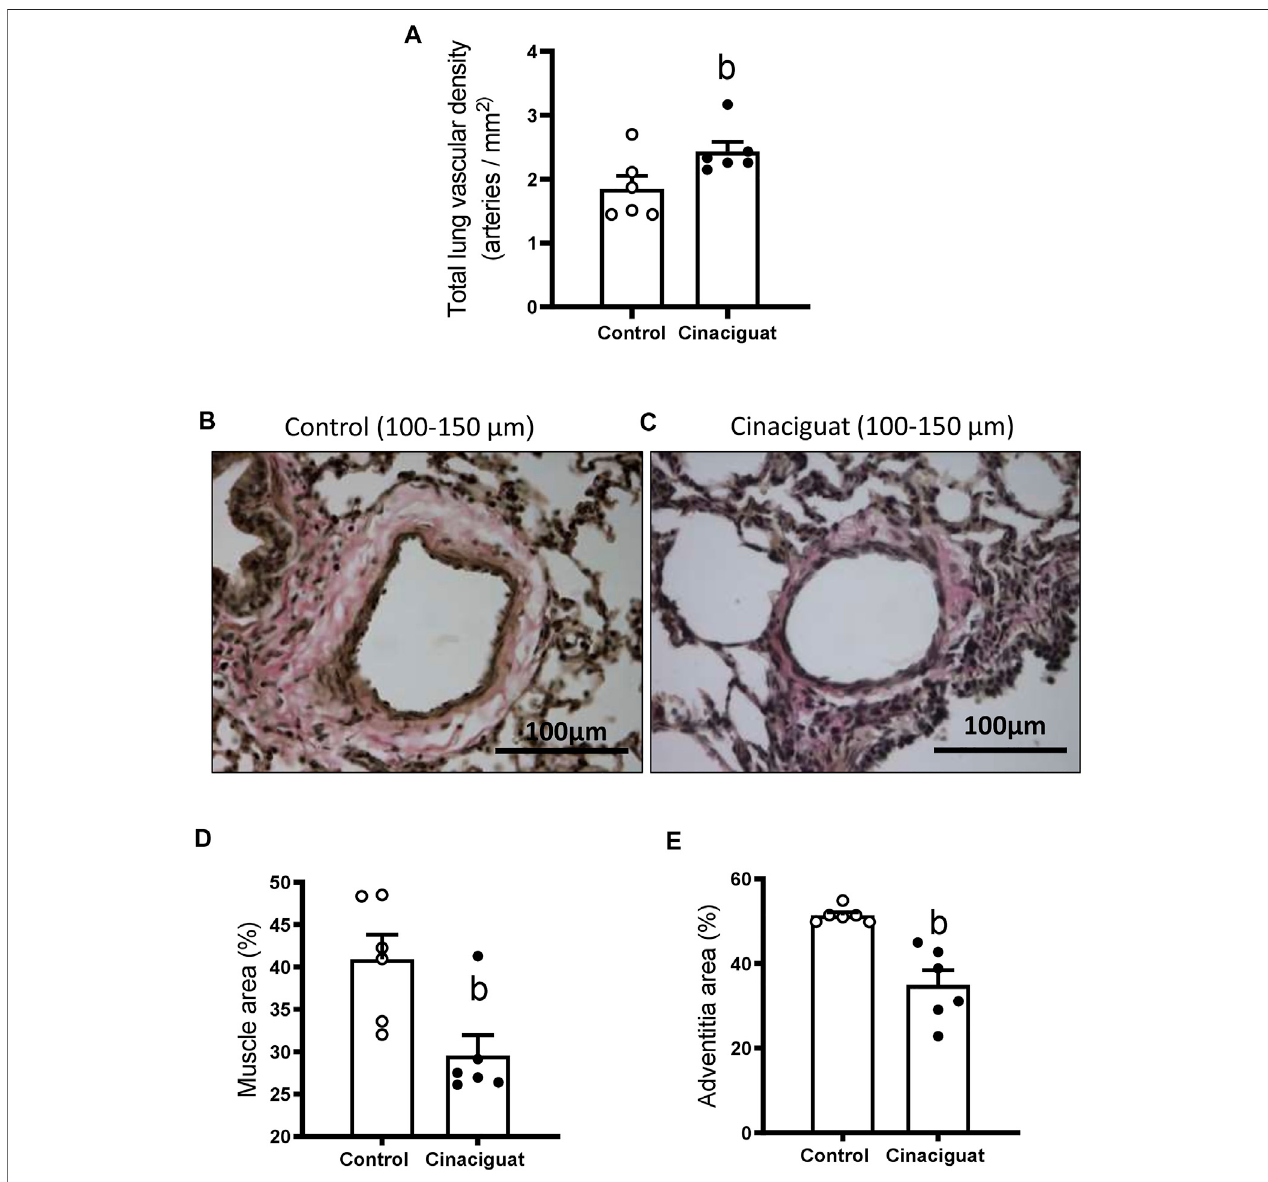
FIGURE 5 | Effect of Cinaciguat treatment on pulmonary vascular density and small pulmonary artery remodeling in chronically hypoxic and pulmonary hypertensiveneonatallambs.Totallungvasculardensity(arteries/mm 2 ) (A) .Representativemicrographofsmallpulmonaryarteries,between100and150 μ mofluminal diameter, from vehicle group (B) and + Cinaciguat group (C) , van Gieson staining. Brown area: muscular layer; pink area surrounding muscle: adventitia layer. Bar: 100 μ m. Magni fi cation: × 40. Percentage of muscle area (D) , percentage of adventitia area (E) . Control (Open circles, n = 6) and Cinaciguat-treated lambs (Black circles, n = 6). Values are means ± SEM. Signi fi cant difference ( p ≤ 0.05): b vs Control group.